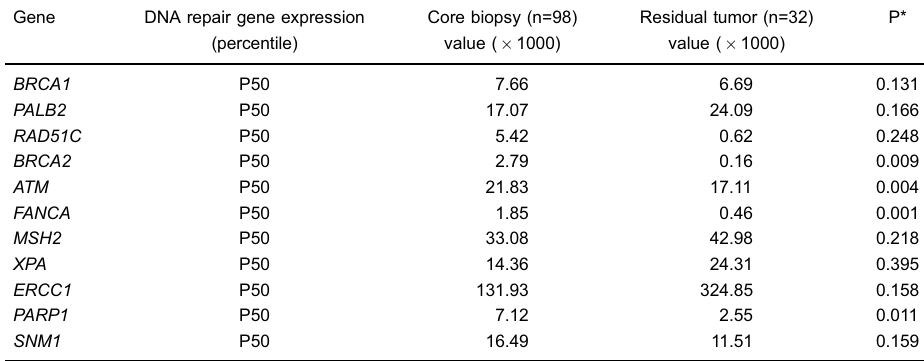
Table 2 . DNA repair gene expression: pre-NACT biopsies vs post-NACT residual tumor. Gene DNA repair gene expression